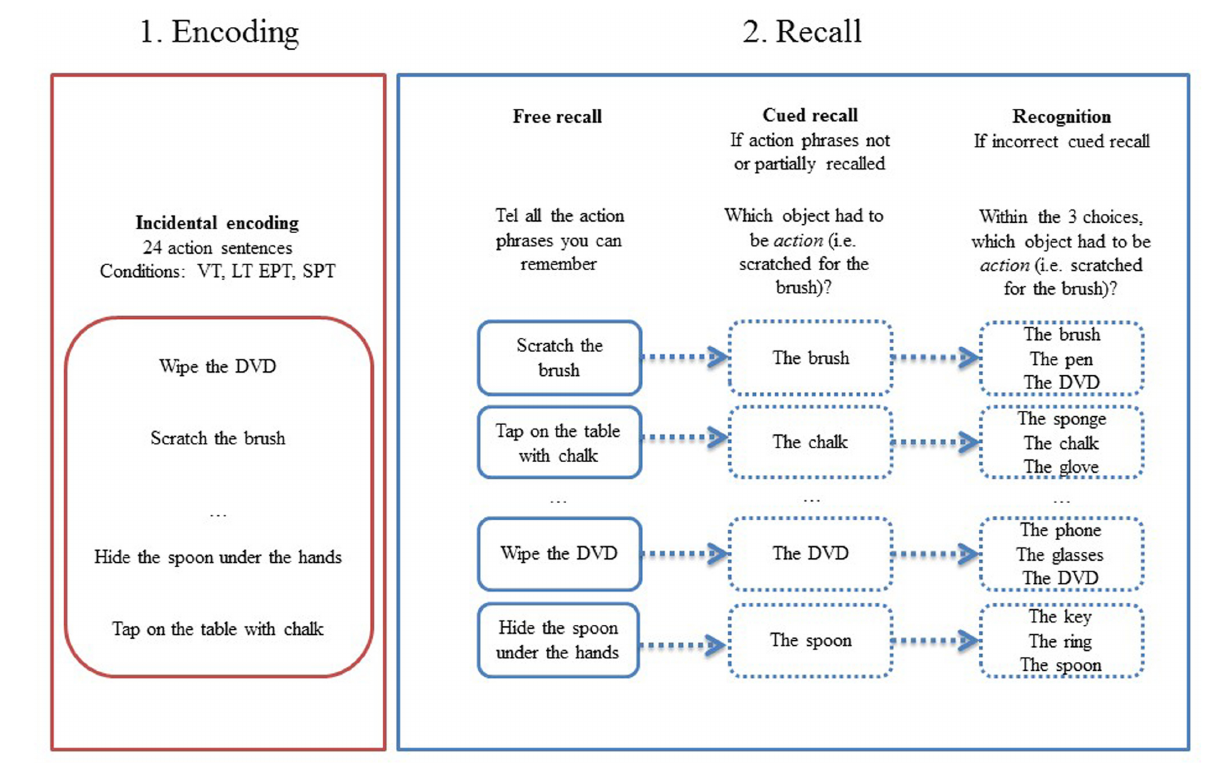
were asked to recall action and objects separately. For each action phrase correctly recalled, participants performed a source memory task, as they had to indicate the encoding condition (i.e., Read, Listen, Watch,